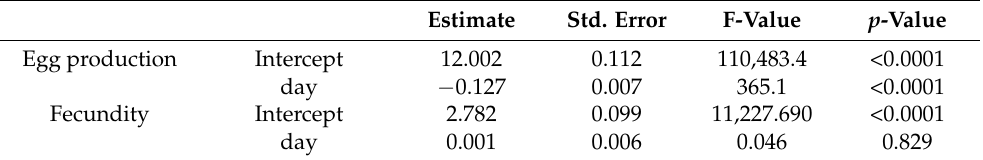
Table 4. Regression parameters for egg production and fecundity over the time since cage assembly.